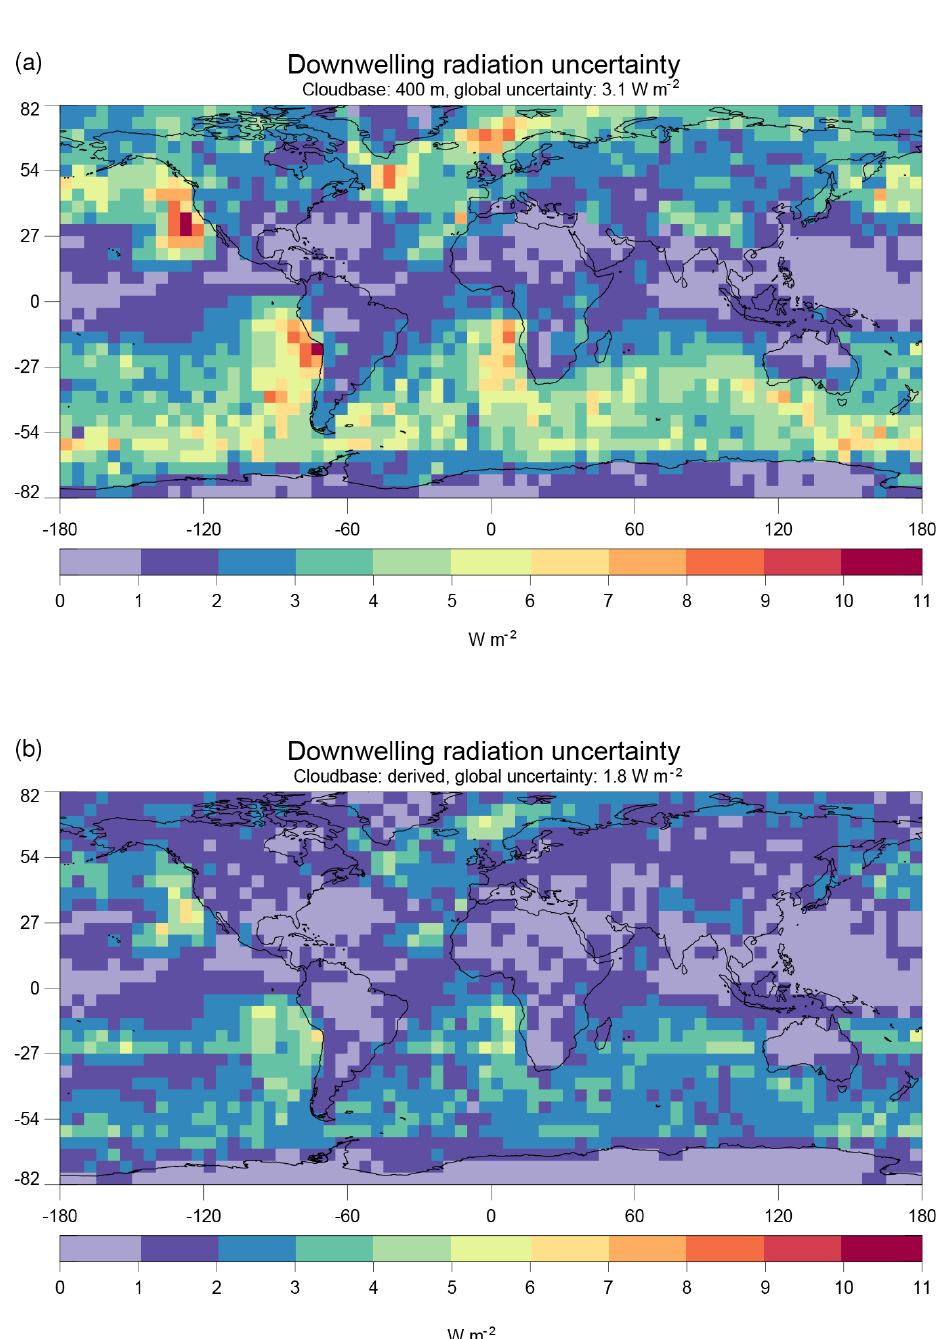
↓ under two assumptions of z uncertainty: (a) constant 400m surf